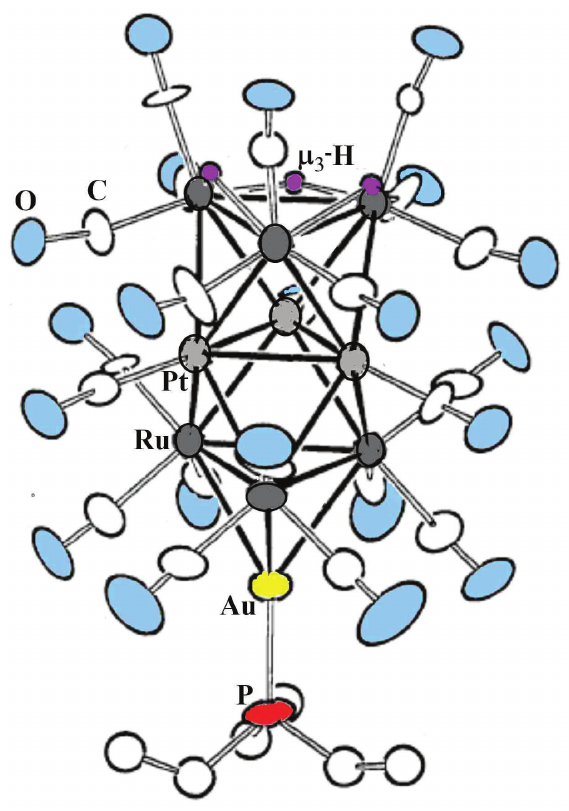
Ru (µ -AuPEt 3 6 3